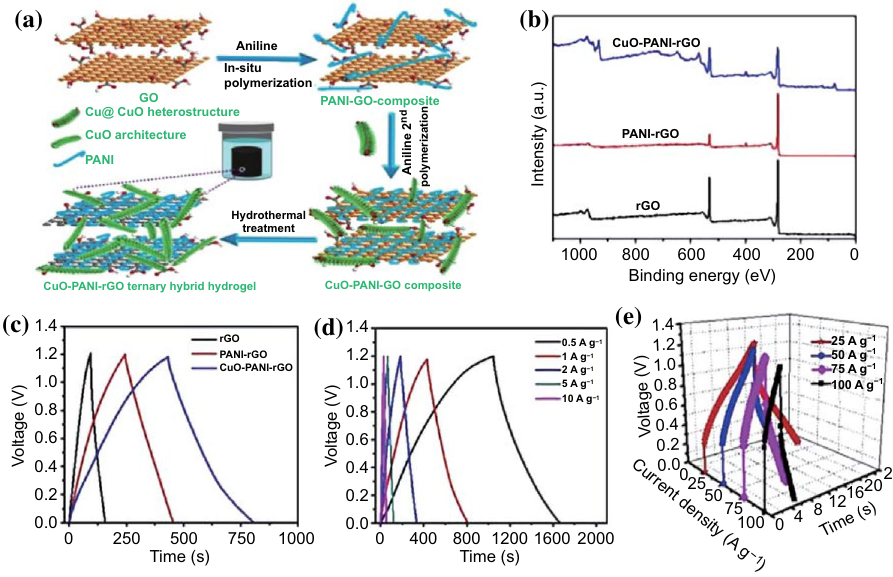
Fig. 10 a Schematic illustration for the self-assembly procedure of the CuO-PANI-rGO ternary hybrid sample. b XPS survey spectra of the typ- ical pure rGO sample, PANI-rGO binary hybrid sample, CuO-PANI-rGO ternary hybrid sample. c GCD curves of the typical CuO-PANI-rGO ternary hybrid sample compared with rGO and PANI-rGO samples at current density of 1.0 A g −1 . d , e GCD curves of the typical CuO-PANI- rGO ternary hybrid sample at different current densities from 0.5 to 10 A g −1 . Adapted with permission from Ref. [76] Copyright 2016